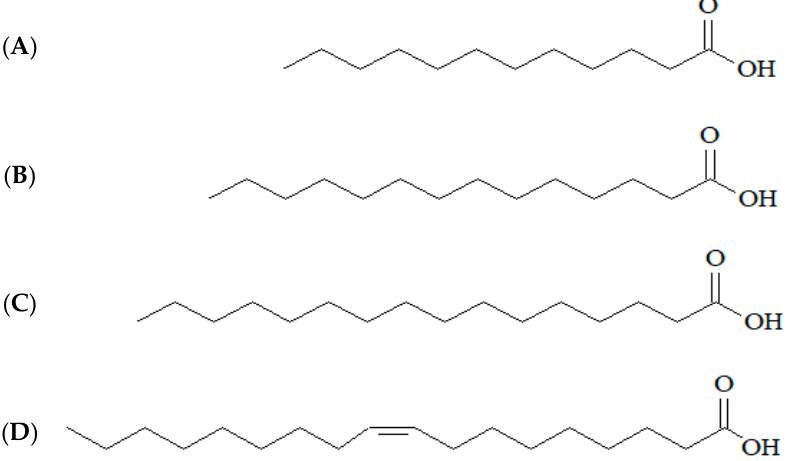
Figure 2. Main constituents identified in the fixed oil of the almond of A. heterophyllus and its structural representation: ( A ) lauric acid, ( B ) myristic acid, ( C ) palmitic acid, and ( D ) oleic acid.